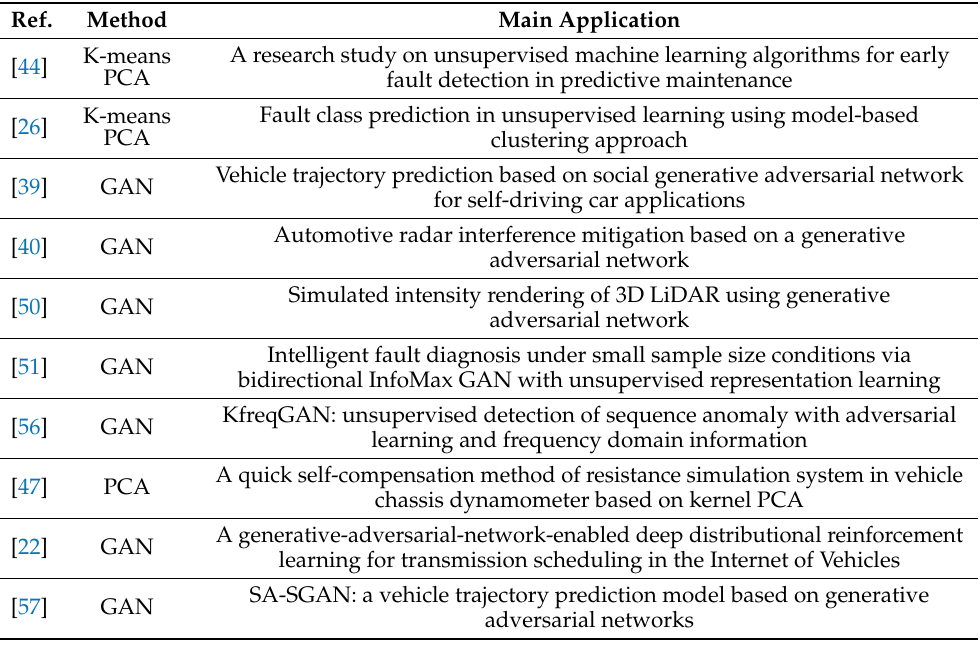
Table 1. Unsupervised